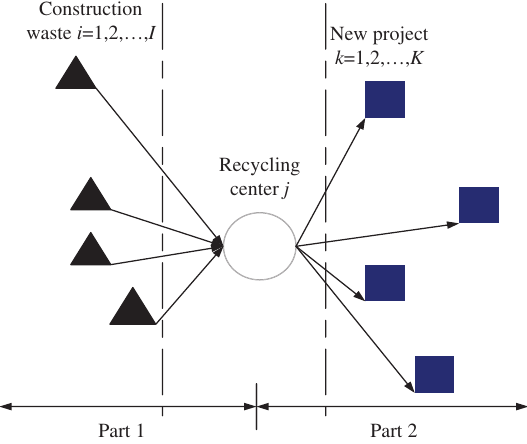
Figure 1. Schematic Diagram of an Individual Recycling